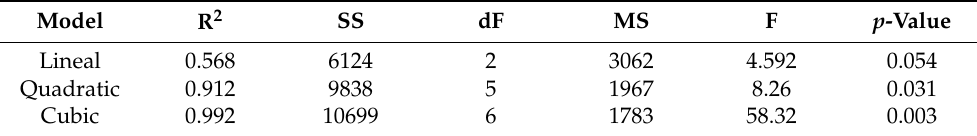
Table A3. F-test for choosing the surface area model.